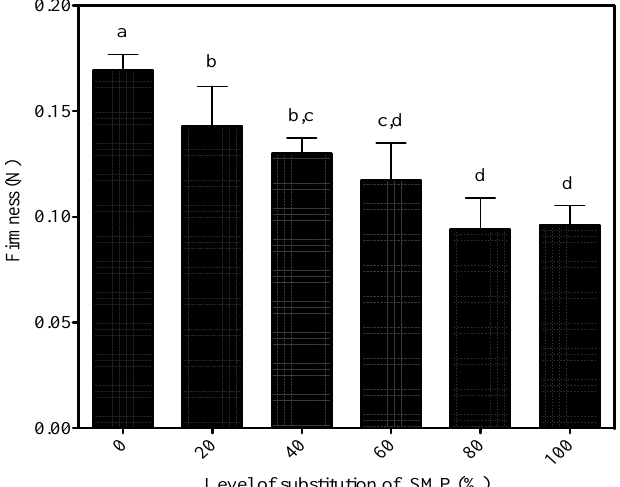
Figure 4. Firmness of control set-type yogurt, and yogurts enriched with whey:buttermilk protein aggregates. A Duncan post-test was applied to compare the means to the control.